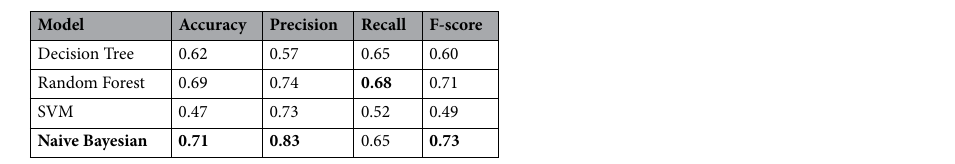
Table 5. The comparison of proposed approach (Naive Bayesian model) and other